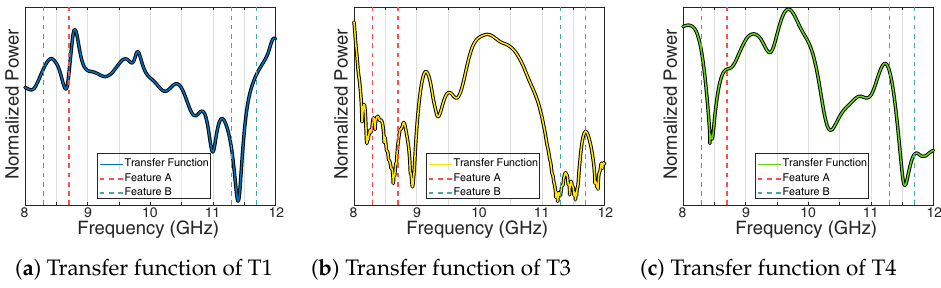
Figure 17. Extracted transfer function of the time gated targets with indicated cross-range